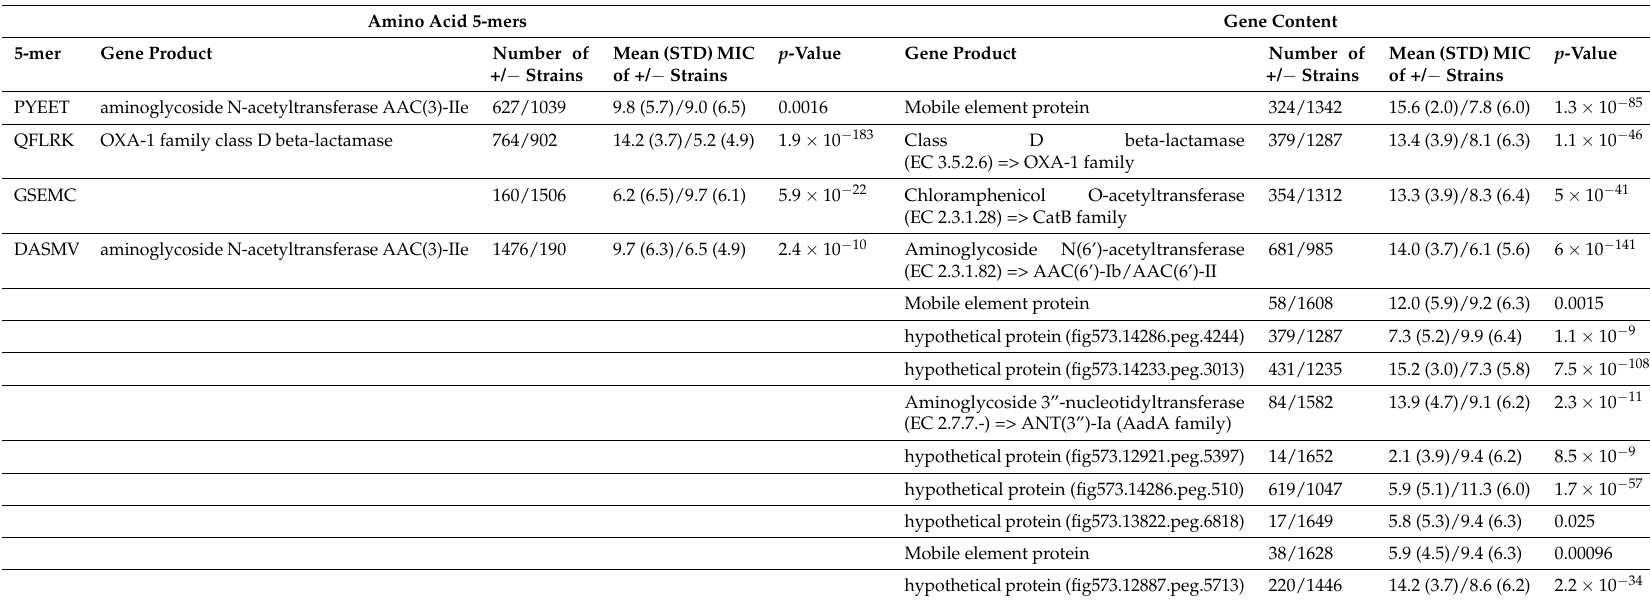
Table A6. Important genes found for K. pneumoniae and tobramycin by amino acid 5-mer gene content